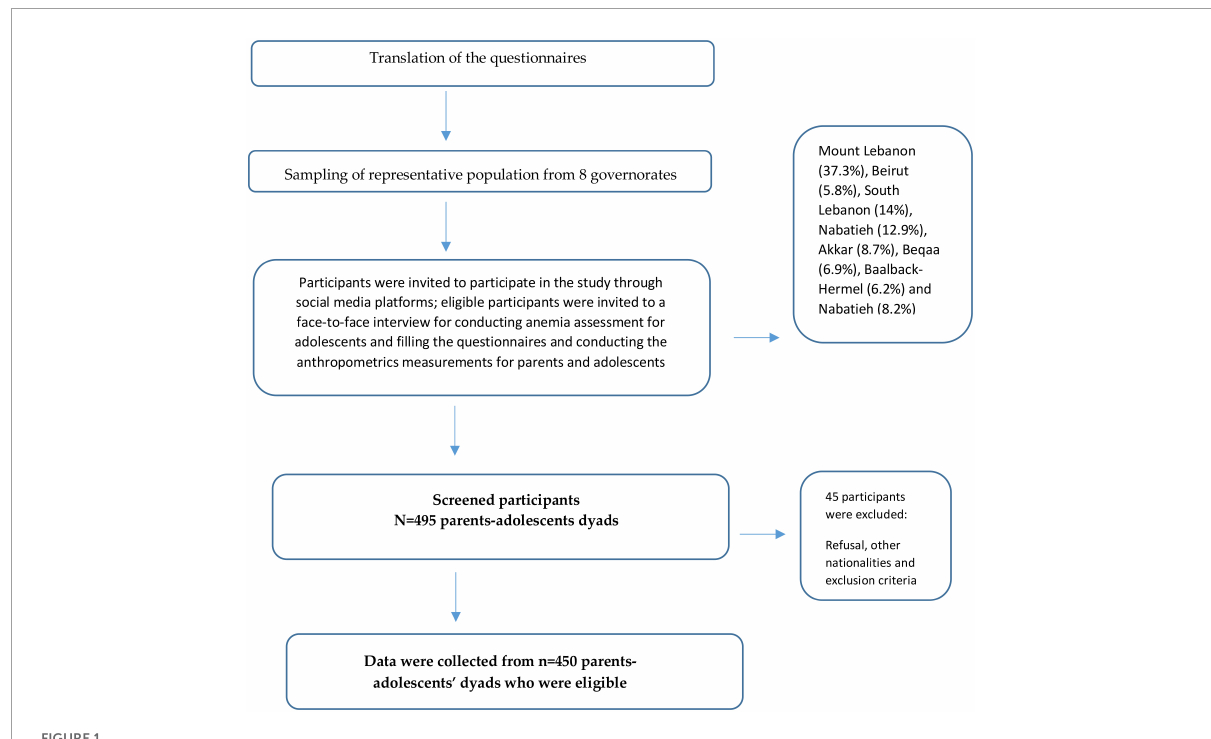
FIGURE1 Flow diagram of the recruitment process in the current